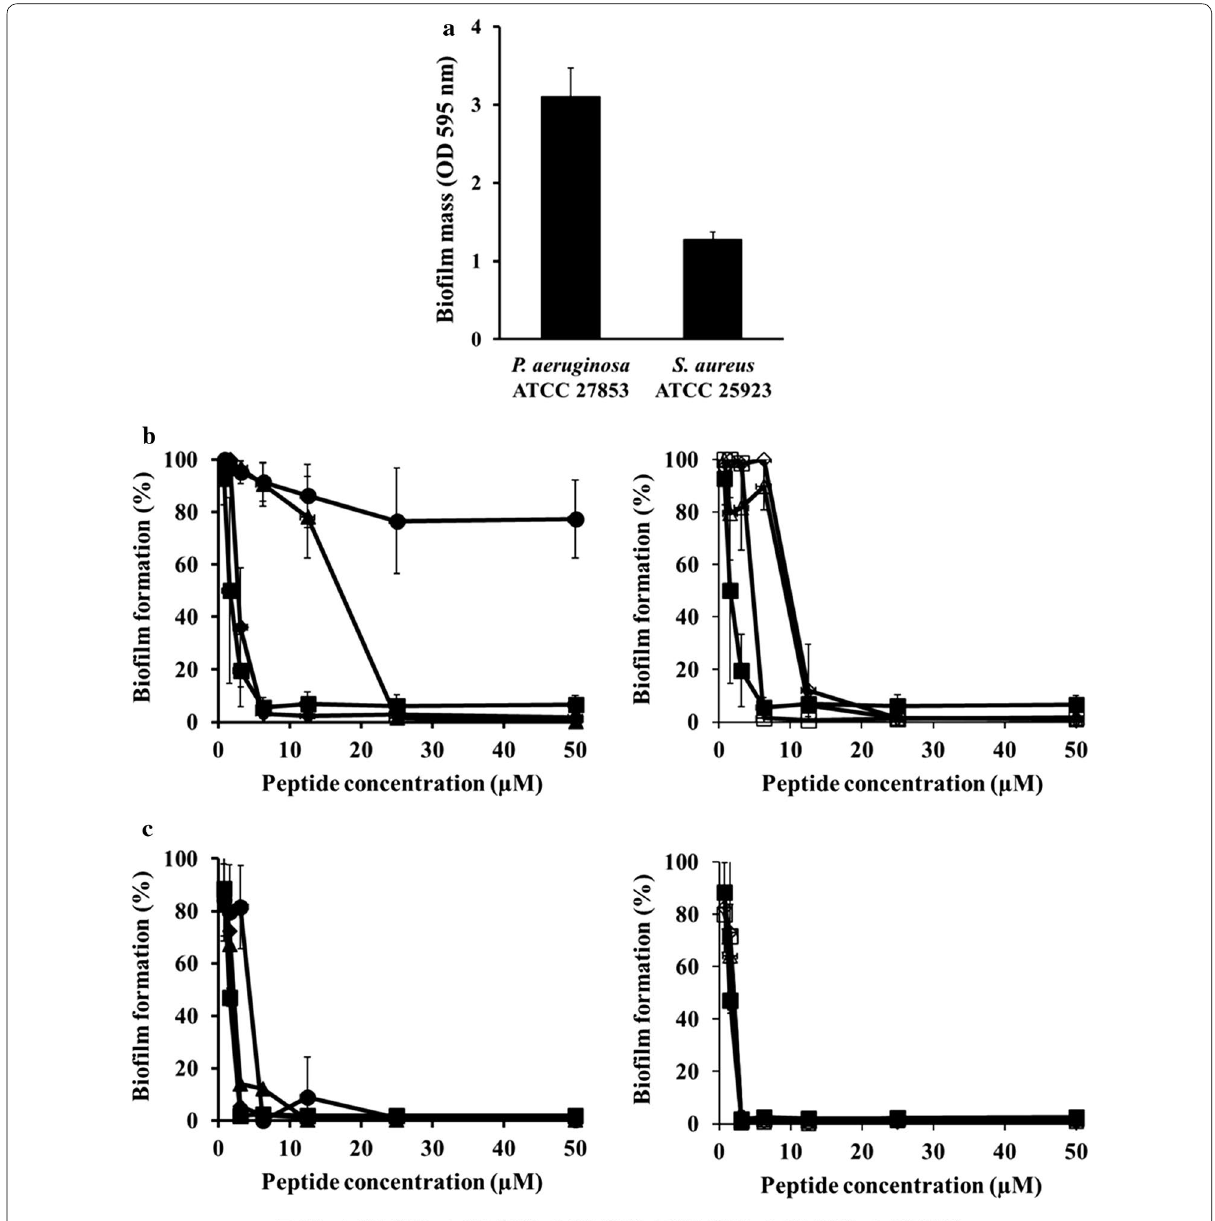
Fig. 3 Inhibition of bacterial biofilm formation by the parent peptide and analog peptides against P. aeruginosa ATCC 27853 and S. aureus ATCC 25923. a Biofilm formation by microorganisms detected by crystal violet staining. Anti-biofilm activity of peptides against b P. aeruginosa ATCC 27853 and c S. aureus ATCC 25923. CT C-terminus, NT